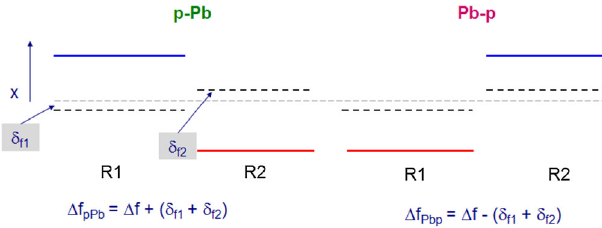
FIG. 11. Principle of the cancellation of systematic errors on the radial position by inversion of the protons and lead ions in the two